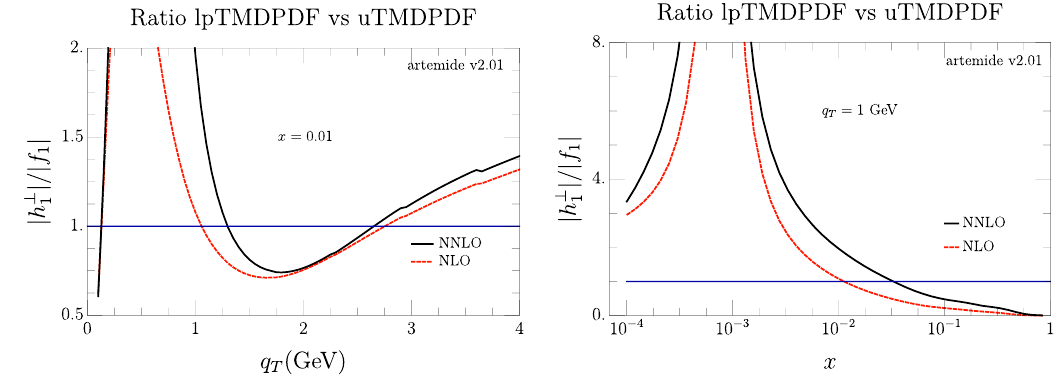
Figure 4 . Ratio of linearly polarized and unpolarized gTMD to check eq. (1.2) as a function of q T at (cid:12)xed x = 0 : 01 (left) and as a function of x at (cid:12)xed q T = 1 GeV